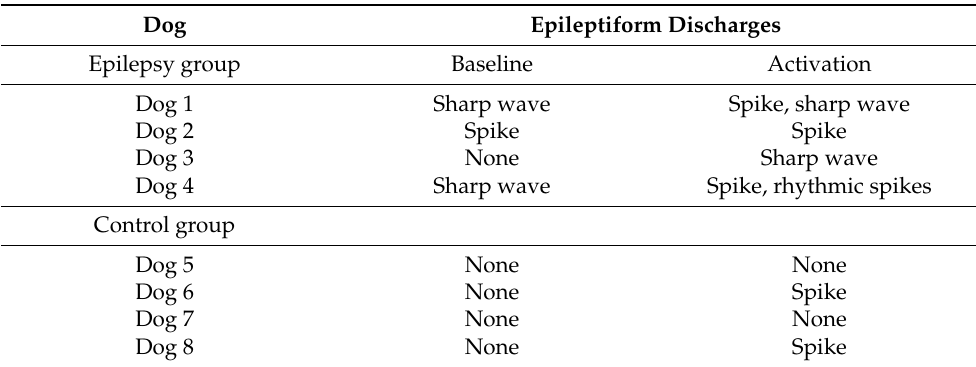
Table 4. Comparison of the type of epileptiform discharges between baseline and activation periods in each dog. Dog Epileptiform Discharges Epilepsy group Baseline